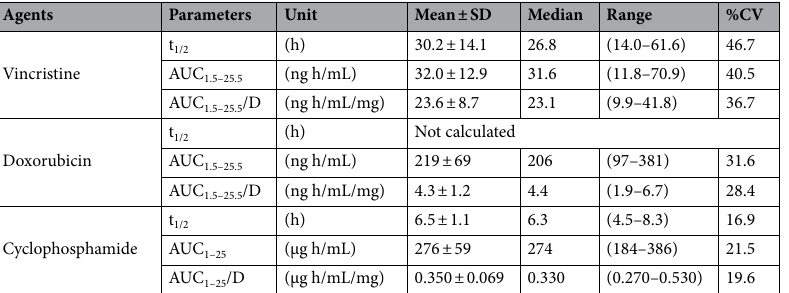
Table 2. Pharmacokinetic parameters of cytotoxic anticancer drugs in all patients (n = 20). AUC n1–n2 , area under the concentration–time curve from n1 to n2 h; AUC n1–n2 /D, dose-adjusted area under the concentration–time curve from n1 to n2 h; t1/2, elimination half-life. %CV, coefficient of